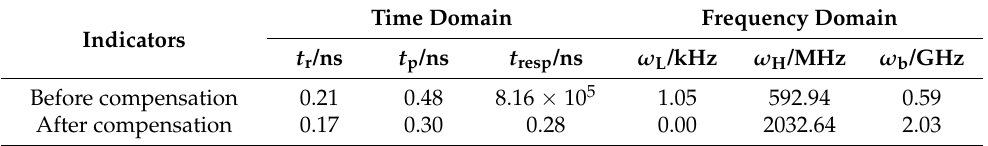
Table 1. Comparison of the system’s dynamic properties before and after compensation.